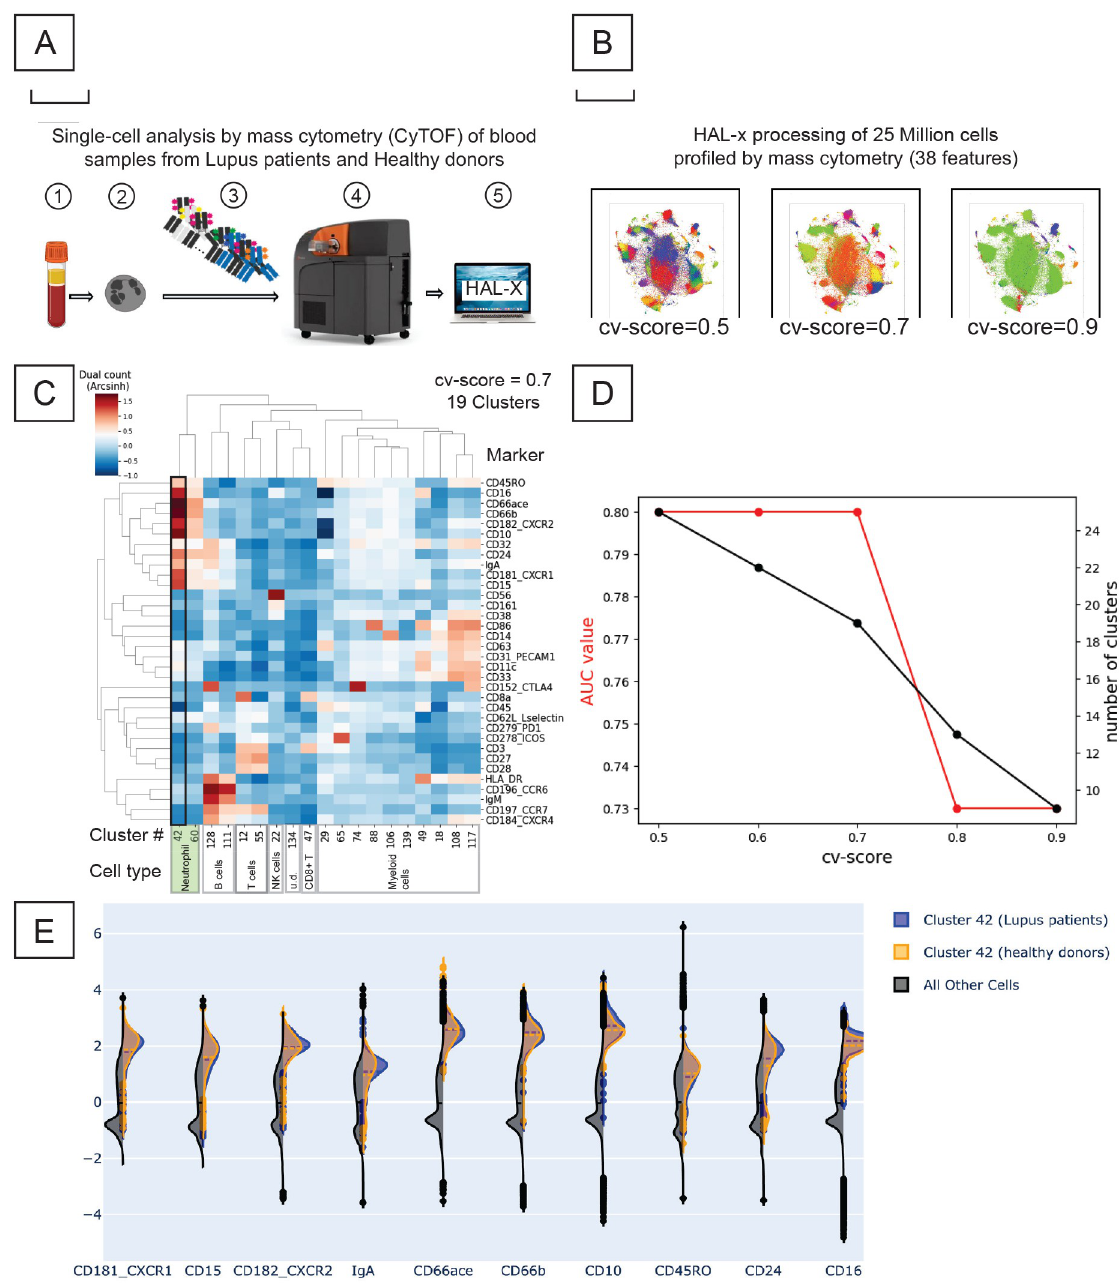
Fig 6. Analysis of Lupus patients’ blood profile using single-cell mass cytometry and HAL-x. (A) The pipeline for profiling immune cells from Lupus patients and healthy donors, beginning with blood collection, continuing with mass cytometry, and culminating with HAL-x processing. (B) t-SNE visualizations of clusterings generated by HAL-x which correspond to various levels of population specificity (cv- score). (C) Heatmap of the average expression levels for the 19 leukocyte clusters defined by HAL-x for a cv-score of 0.7. The Cell type annotations were made hand. (D) A graph of AUC ( i.e . Area under the Receiver Operating Curve (ROC)) for different cv-scores shows that the most important clusters with discriminatory power are not observed for high CV-scores. The best cluster identified by HAL-x (cluster #42 for cv-score of 0.7), separates individual neutrophils from Lupus and Healthy patients with an AUC of 0.82. (E) Markers on neutrophils (cluster #42) that can be used to distinguish blood samples from Lupus patients and from healthy donors. Note how subtle the difference is at the level of individual